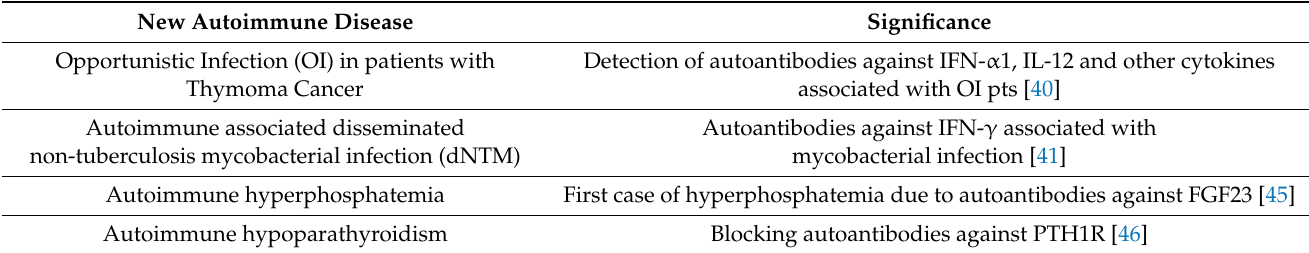
Table 2. Serology-Enabled Discovery of New Autoimmune